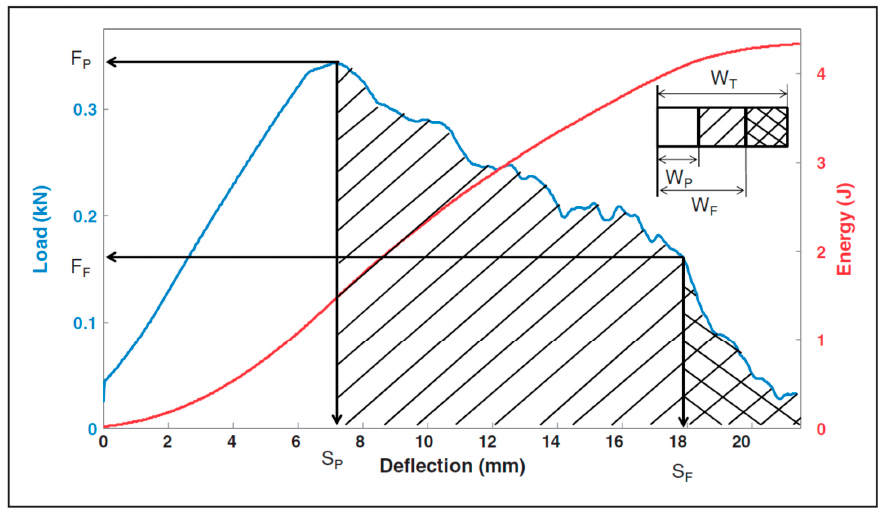
Figure 7. Deformation force diagram for an impact load tested specimen [40].